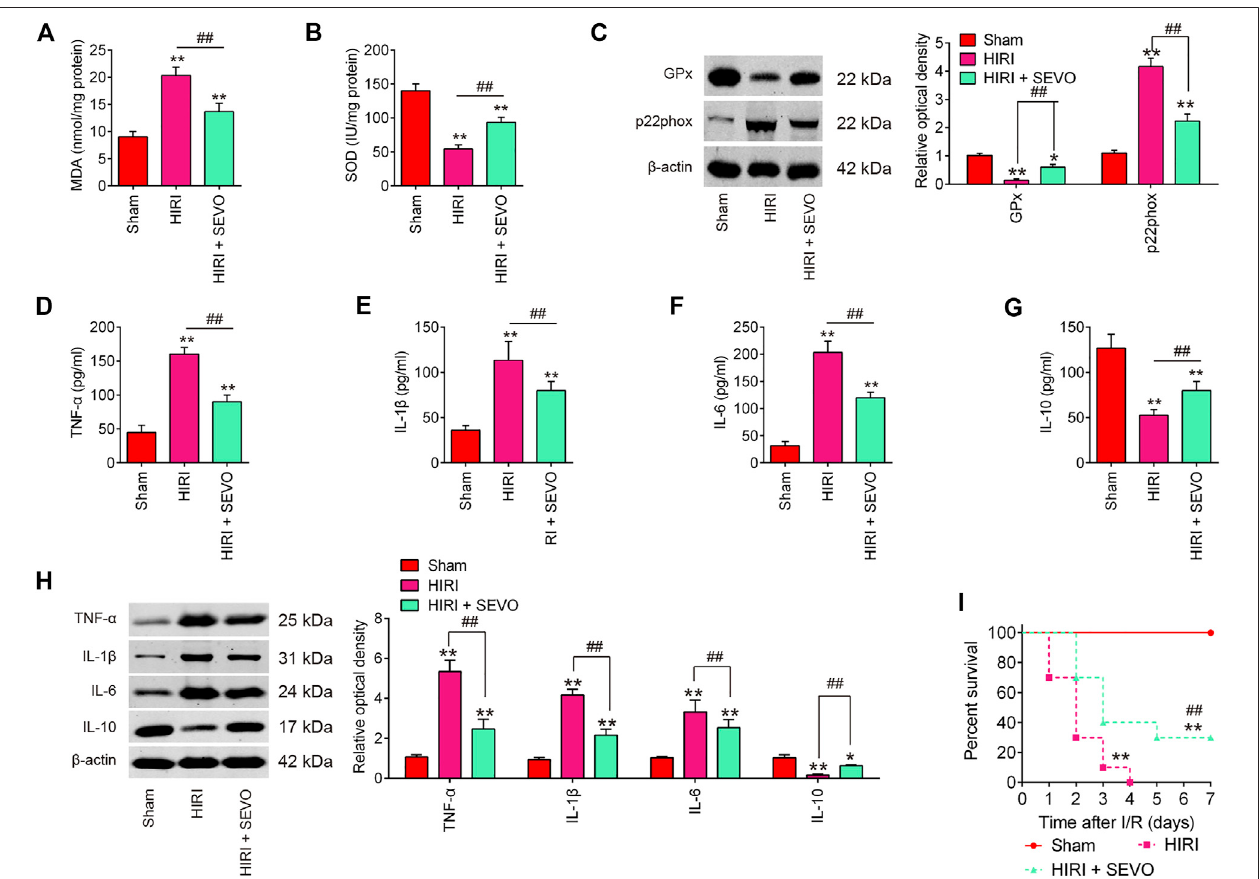
FIGURE 2 | Sevo fl urane postconditioning attenuates oxidant stress and in fl ammatory response. Mice were subjected to ischemia, then post-treatment with inhalation of 2% Sevo for 2 h immediately at the onset of reperfusion. (A, B) The contents of MDA and SOD were measured by ELISA assays ( n (cid:2) 6/group). (C) The expressions of GPx and p22phox were detected by Western Blot ( n (cid:2) 6/group). (D – G) The in fl ammatory cytokines including TNF- α , IL-1 β , IL-6, and IL-10, were evaluated by ELISA assays ( n (cid:2) 6/group). (H) The protein expressions of TNF- α , IL-1 β , IL-6, and IL-10 were determined by Western Blot ( n (cid:2) 6/group). (I) Animal survivalwasrecordedattheindicatedtimepoints( n (cid:2) 10/group).Alldataweremeasurementdatawhichwereexpressed asmean ± standarddeviationandanalyzedby one-way analysis of variance. * p < 0.05, ** p < 0.01 vs. Sham group; ## p < 0.01 vs. HIRI group.